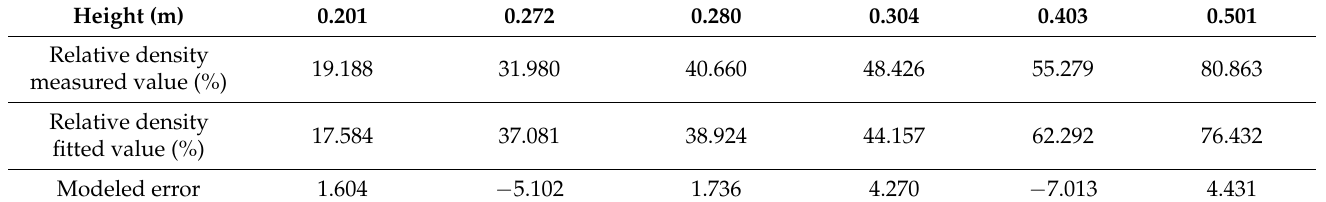
Table 2. Modeled error of relationship curve of falling distance and relative compaction.